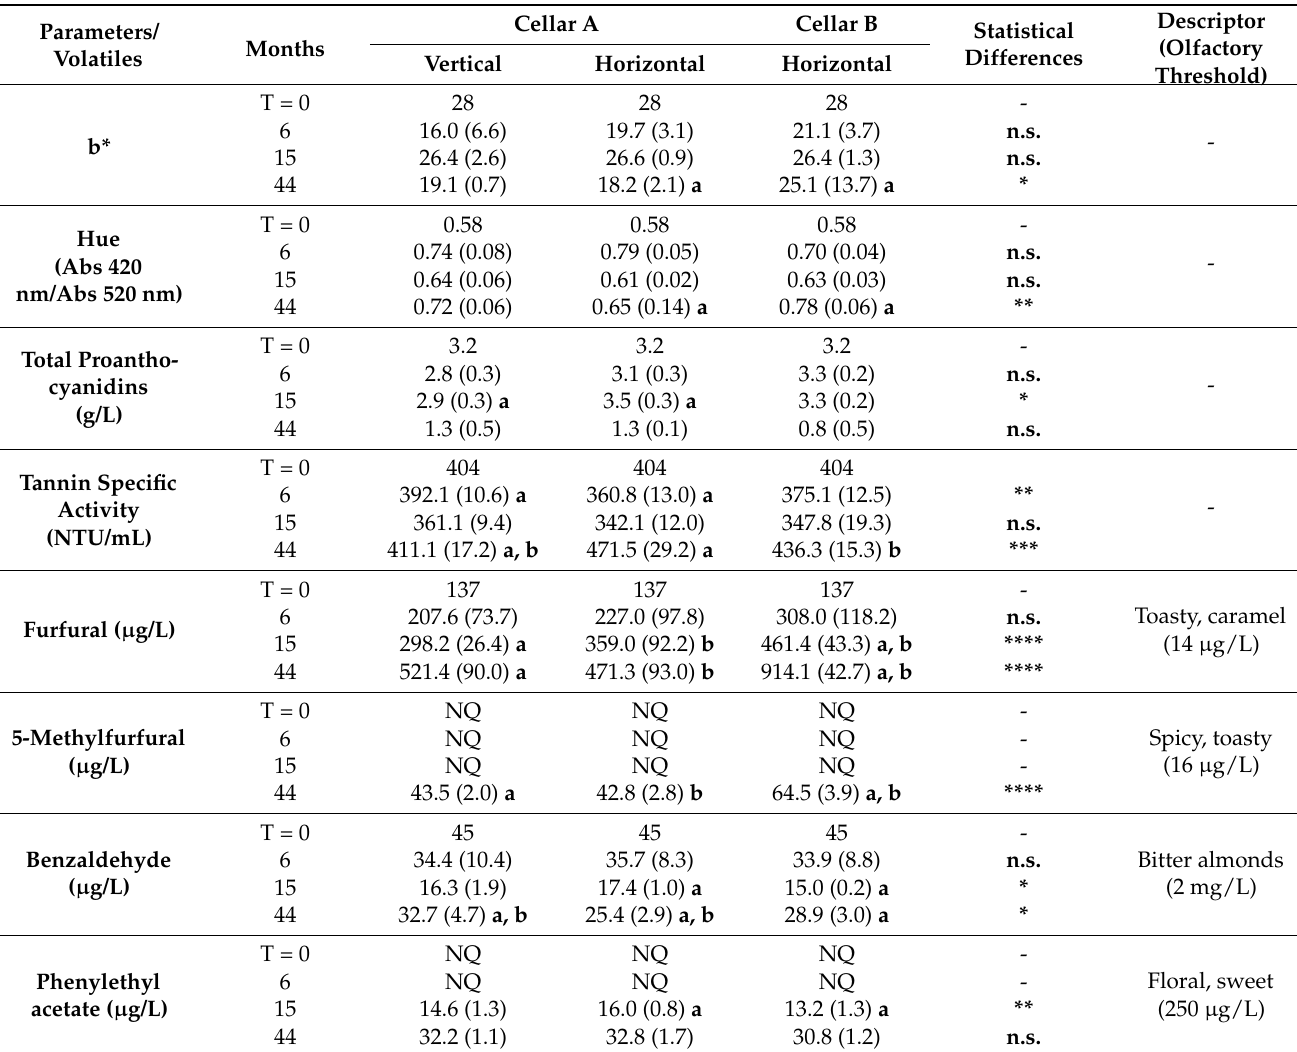
Table 2. Color, phenolic parameters and volatile composition of Vintage Port wine stored under different cellar conditions and bottle orientation for 44 months in bottle ( n =